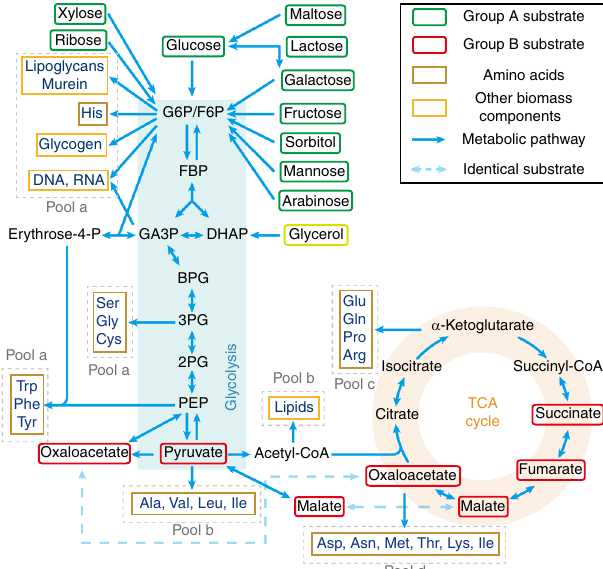
Fig. 1 Metabolic network of carbon source utilization. Group A substrates (in green frames) can be simultaneously utilized with Group B substrates (red frames), whereas substrates paired from Group A usually display diauxie. Only the major pathways are shown. The precursors of biomass components (amino acids marked with light brown frames and other components marked with orange frames) are classi fi ed into Pools a – d (marked with gray dashed line frames). The enzyme for the interconversion between Glucose 6-phosphate (G6P) and fructose 6-phosphate (F6P) is very ef fi cient (Supplementary Table 1), so we approximate G6P/F6P as a single node for convenience. All Group A carbon sources enter the metabolic network through G6P/F6P, while Group B carbon sources enter the metabolic network from different points after glycolysis. Glycerol enters from the upper part of glycolysis but not G6P/F6P, thus we classify glycerol as a quasi-Group A carbon source (see Supplementary Note 1.4 for